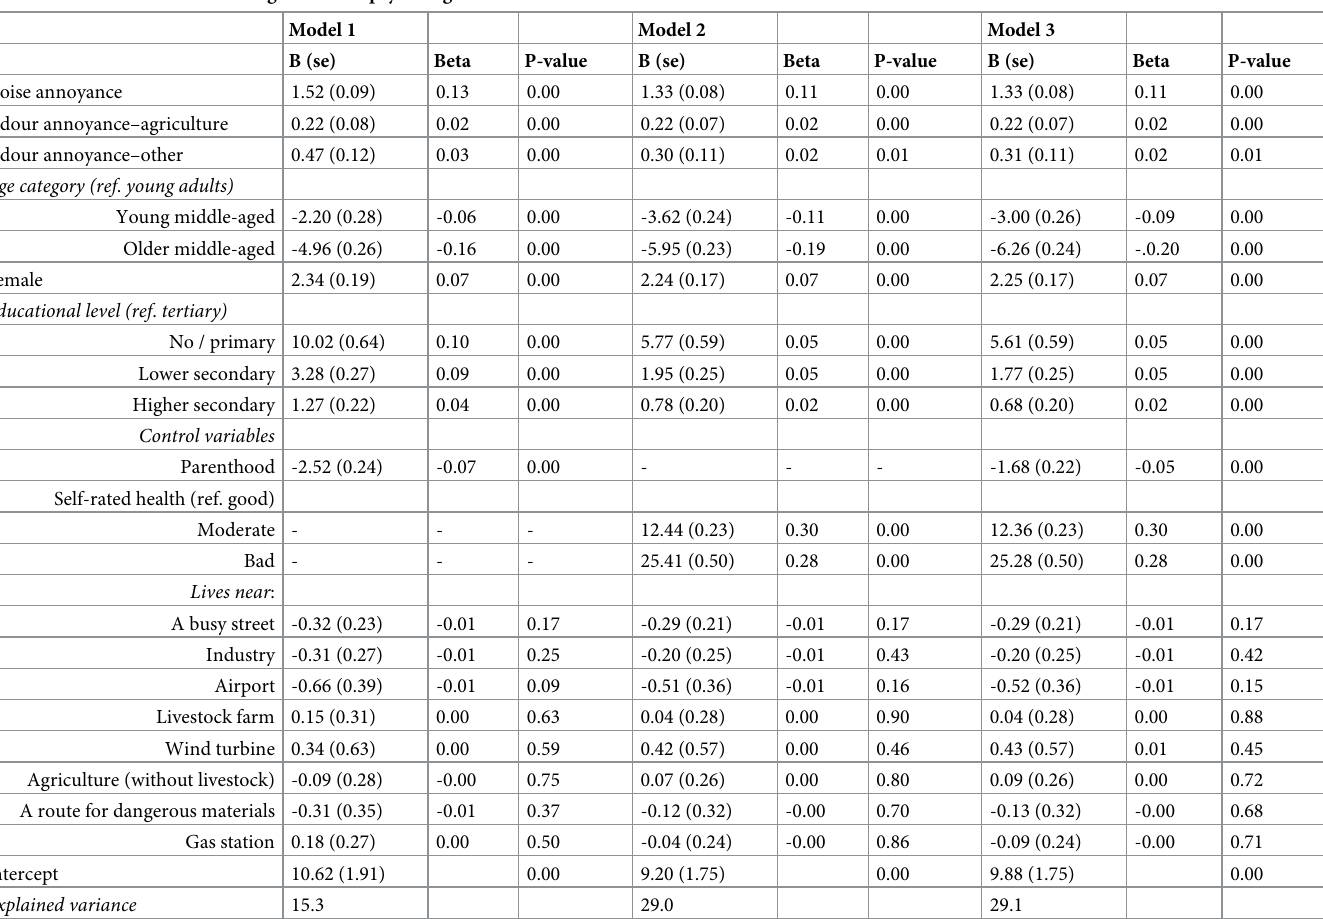
Table 3. Selected effects of OLS regression for psychological distress.